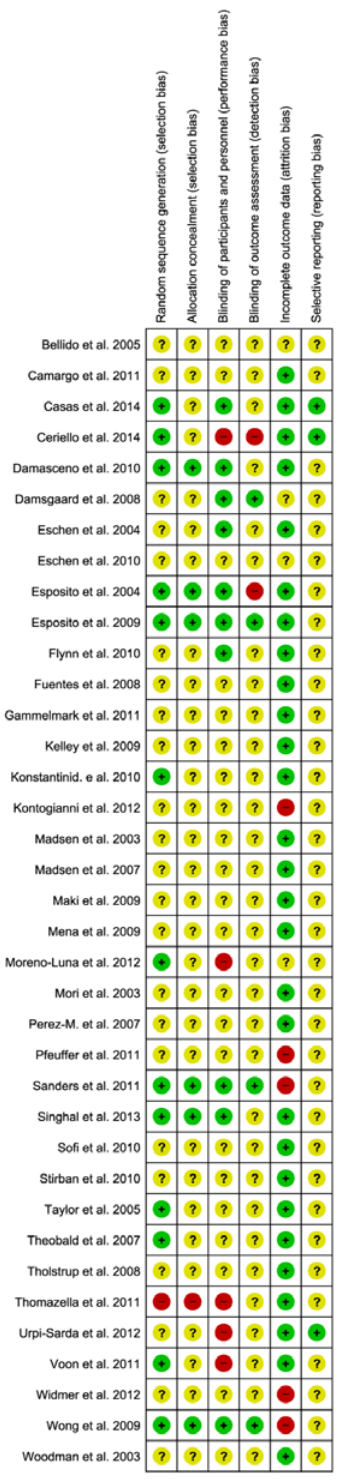
Figure 2. Risk of bias assessment tool. ( A) Across trials, information is either from trials at low risk of bias (green), or from trials at unclear risk of bias (yellow), or from trials at high risk of bias (red). ( B) For each study, every bias domain will be checked, the given summary represents an assessment of bias risk across studies. For each bias domain, low risk of bias means that information is from studies at low risk of bias (green), high risk of bias indicates the proportion of information from studies at high risk of bias which might be sufficient to affect the interpretation of the results (red), and unclear risk of bias refers to information from studies at low or unclear risk of bias